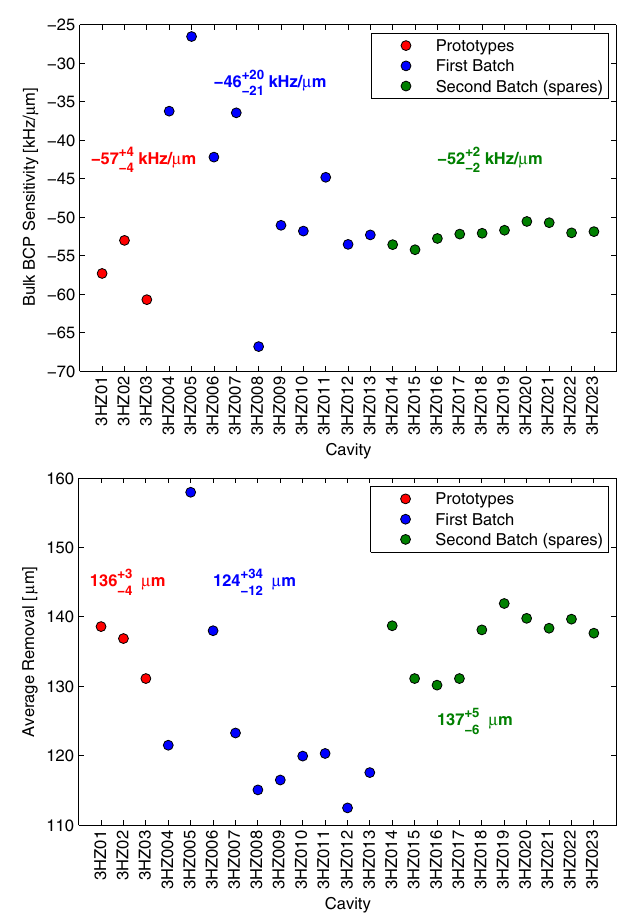
FIG. 7. Above: Individual frequency response of the cavities to the bulk BCP etching (in units of kHz = μ m of average material removal). An increased stability has been achieved in the treat- ments of the second batch. Below: Average thickness removal from the cavity during the treatments (140 min for Prototypes, 110 min for the 1st batch and 120 min for the 2nd batch). The labels indicate the average value and the uncertainty of the